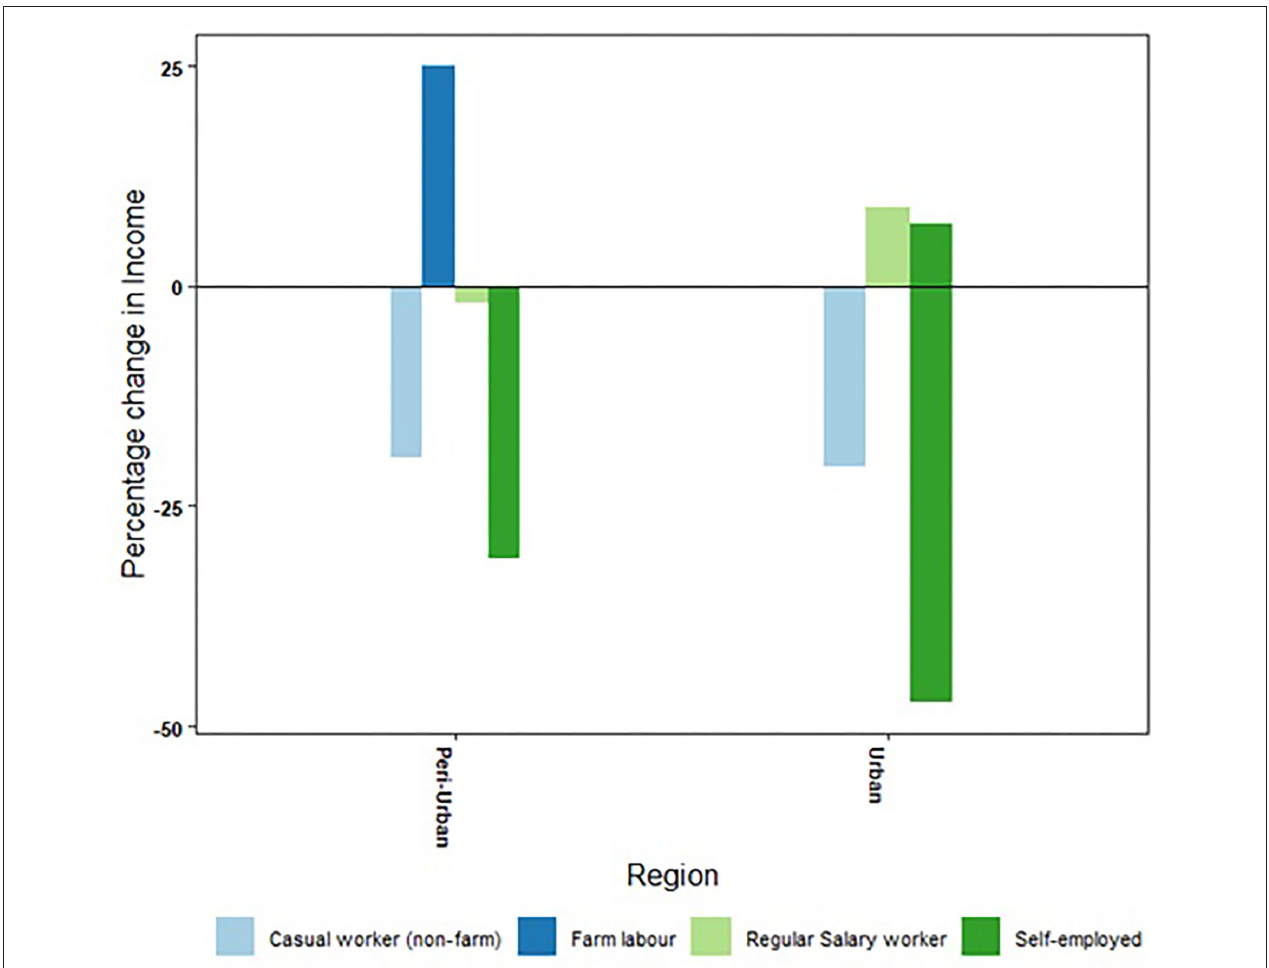
FIGURE 3 | Change in income experienced by various categories of workers during the lockdown and unlock phases of the COVID-19 pandemic in urban and peri-urban areas of Hyderabad, India.